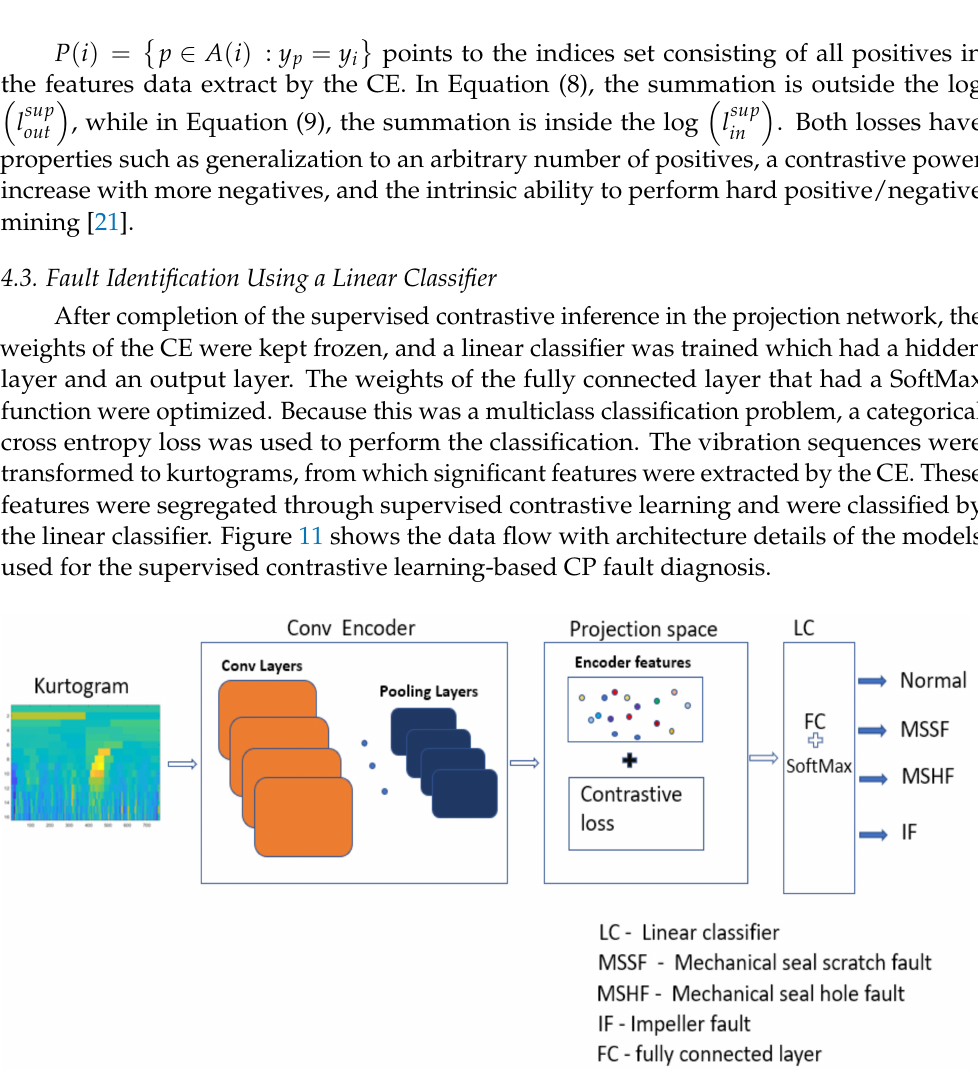
Figure 11. Flow diagram of feature extraction, contrastive learning, and